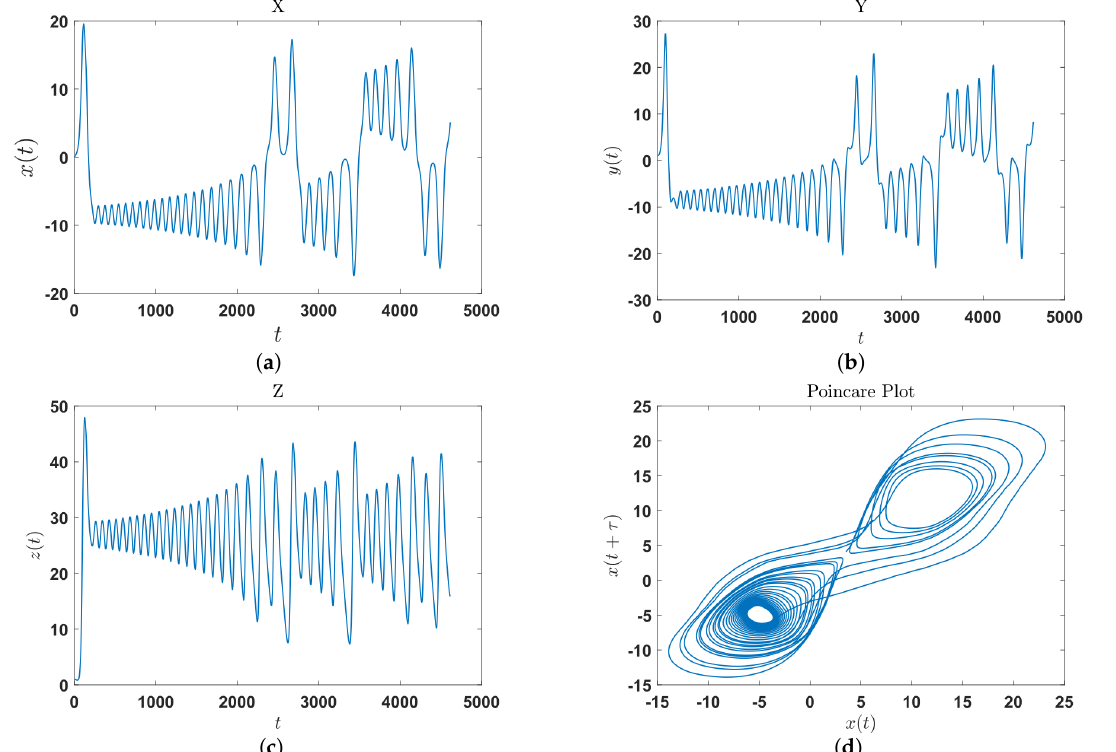
Figure 4. Bi-dimensional representation of Lorenz model. ( a ) Time evolution of x ( t ) . ( b ) Time evolution of y ( t ) . ( c ) Time evolution of z ( t ) . ( d ) Poincaré plot for x ( t ) . The lag used for the Poincaré plot is τ = 20.